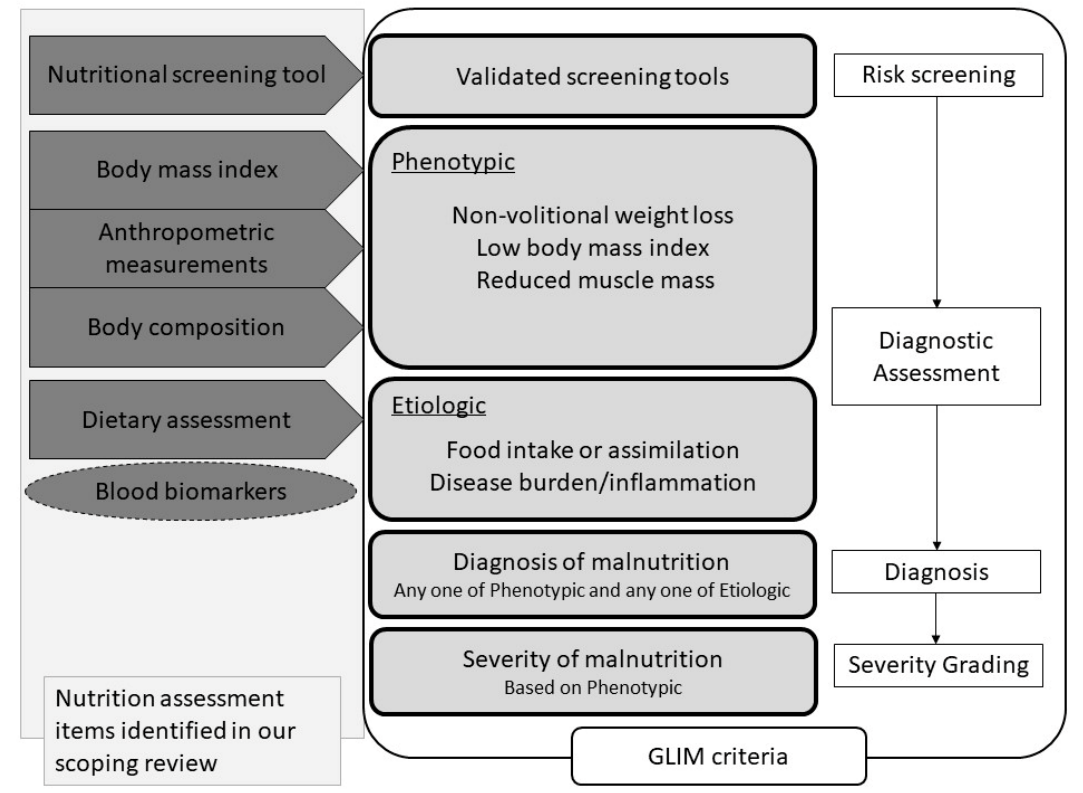
Figure 2. Flowchart for nutritional diagnosis using the GLIM criteria and nutritional assessment components. The nutritional assessment items identified in this review are listed on the far left. Among the items identified in this study, the components of the GLIM criteria are nutritional screening tools, BMI, anthropometric measurements, body composition, and dietary assessment. Blood biomarkers are surrounded by a dotted line because the GLIM criteria recommend their use as adjunct indicators of disease burden/inflammation. Abbreviations: GLIM, Global Leadership Initiative on Malnu- trition.